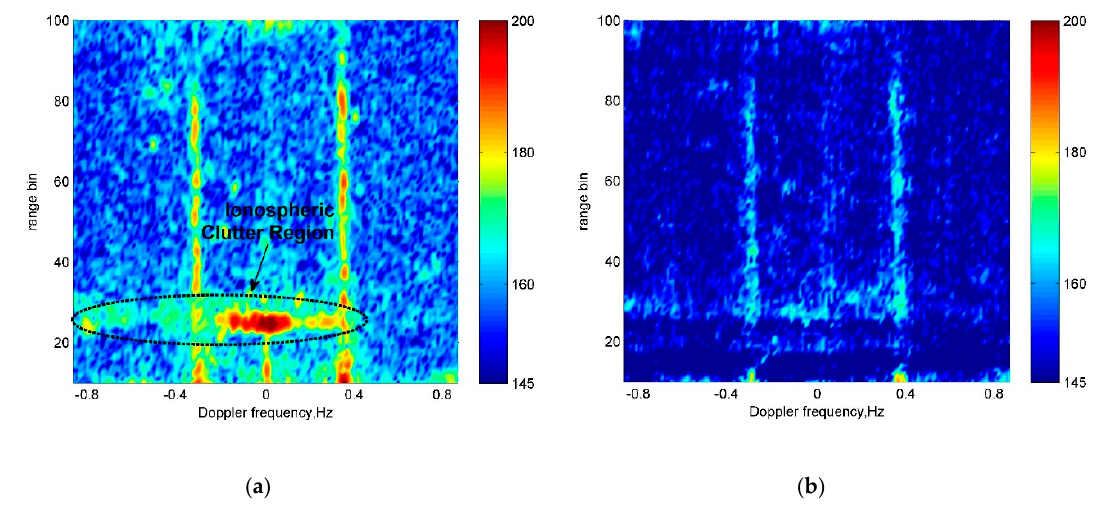
Figure 10. Experimental results using the measured data with ionospheric clutter, ( a ) Range-Doppler map of DBF method, ( b ) Range-Doppler map of LE-JDL method.